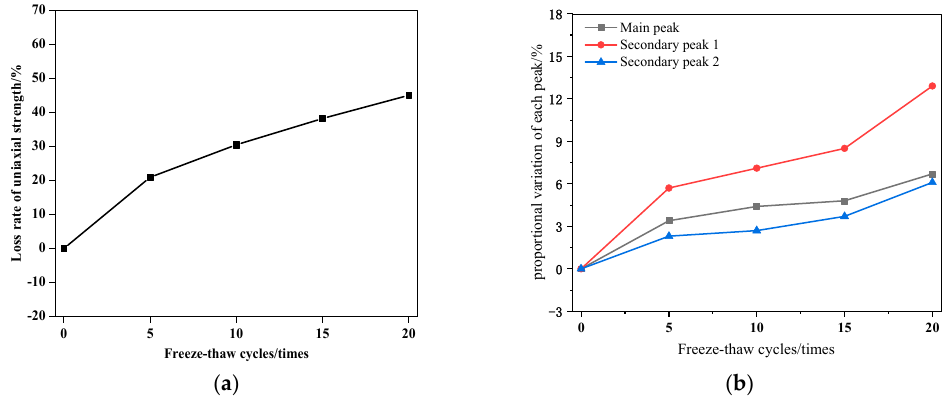
Figure 7. Relationship between intensity loss rate and variation of spectral area ratio of each peak and number of freezing–thawing cycles: ( a ) strength loss rate; ( b ) changes in spectral area ratio of each peak.